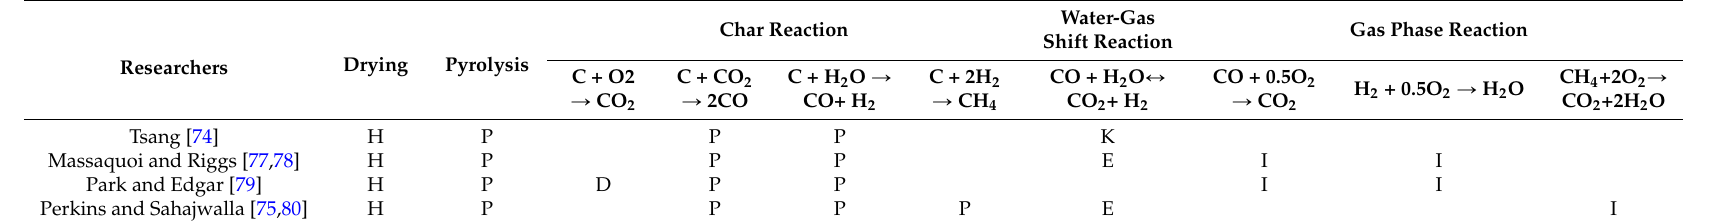
Table 17. Reaction rate control mechanisms of the main reactions in the gasification